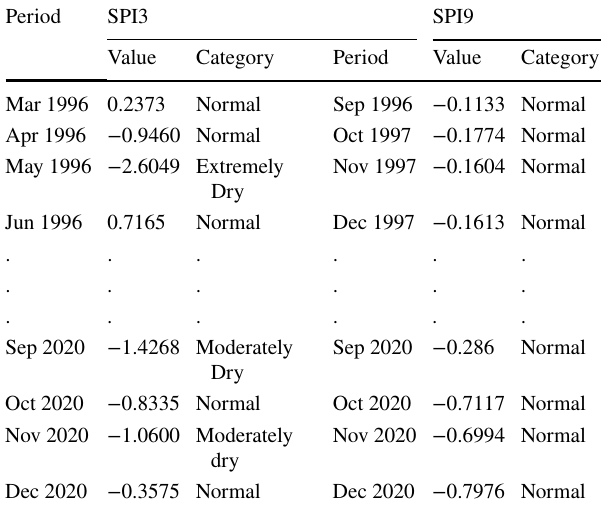
Table 5 Determination of drought characteristics by SPI index in